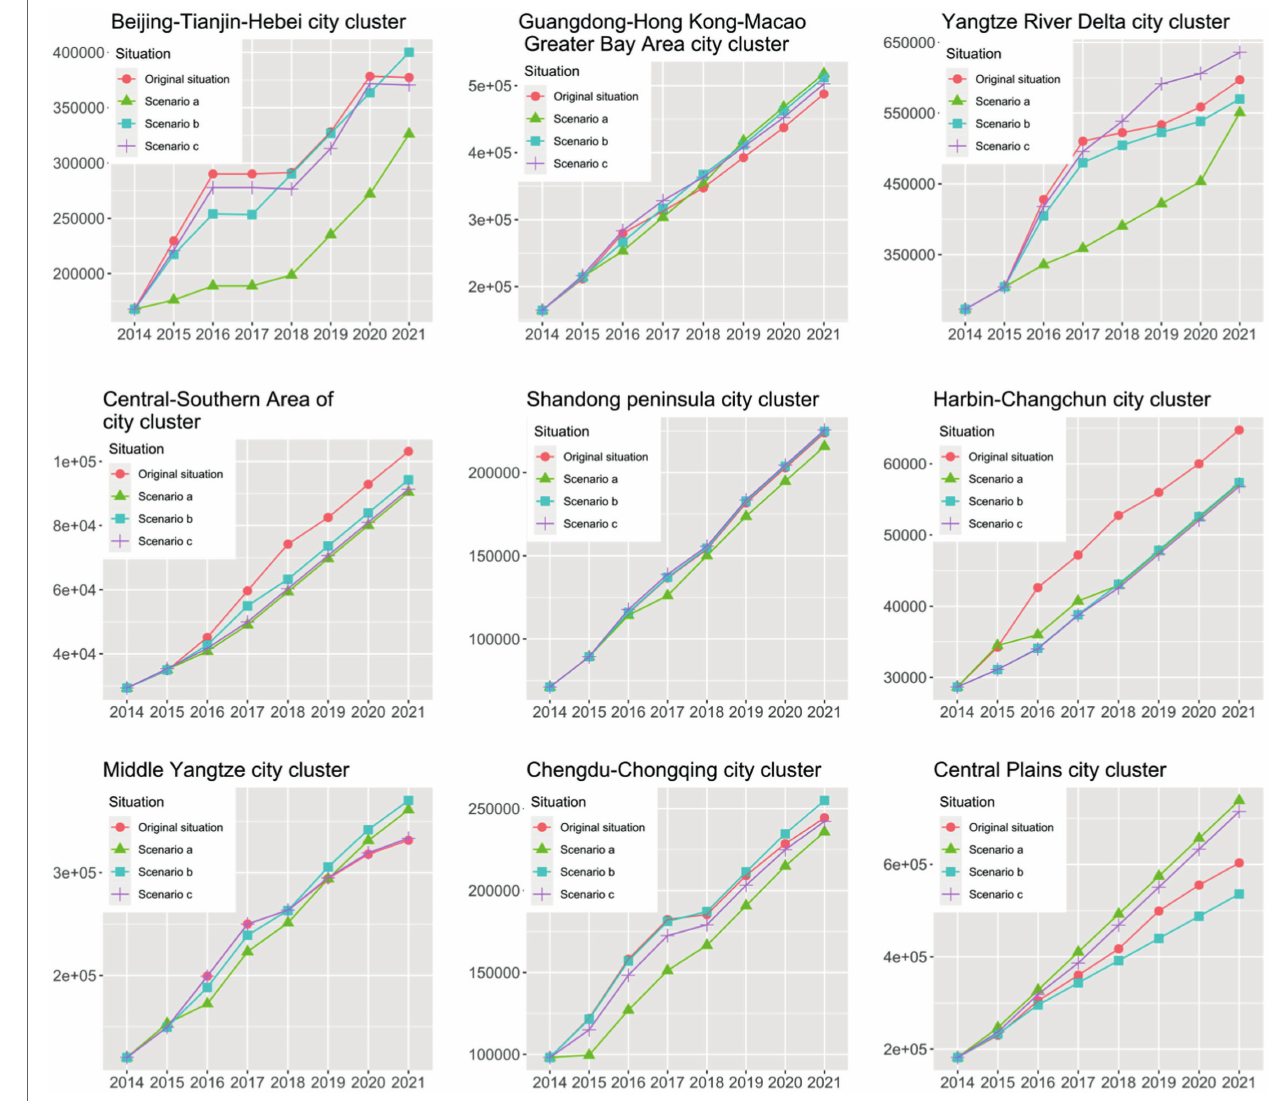
FIGURE 7 | Results of simulation projections and sensitivity analysis of the number of new enterprises per year in urban